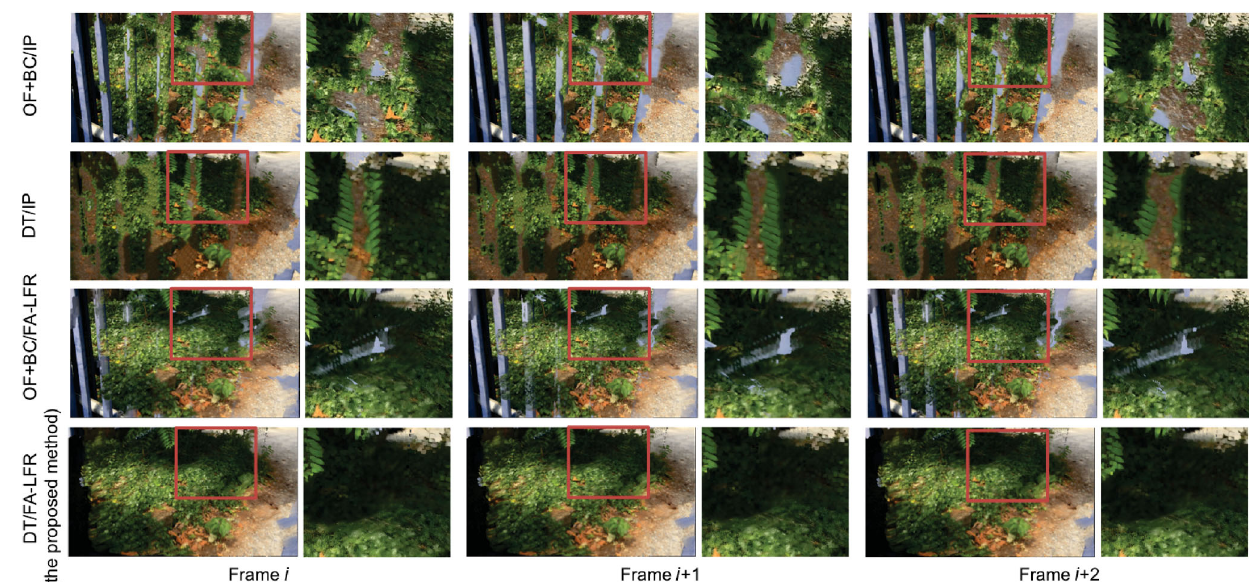
Fig. 13 Comparison of background restoration for consecutive frames of Scene